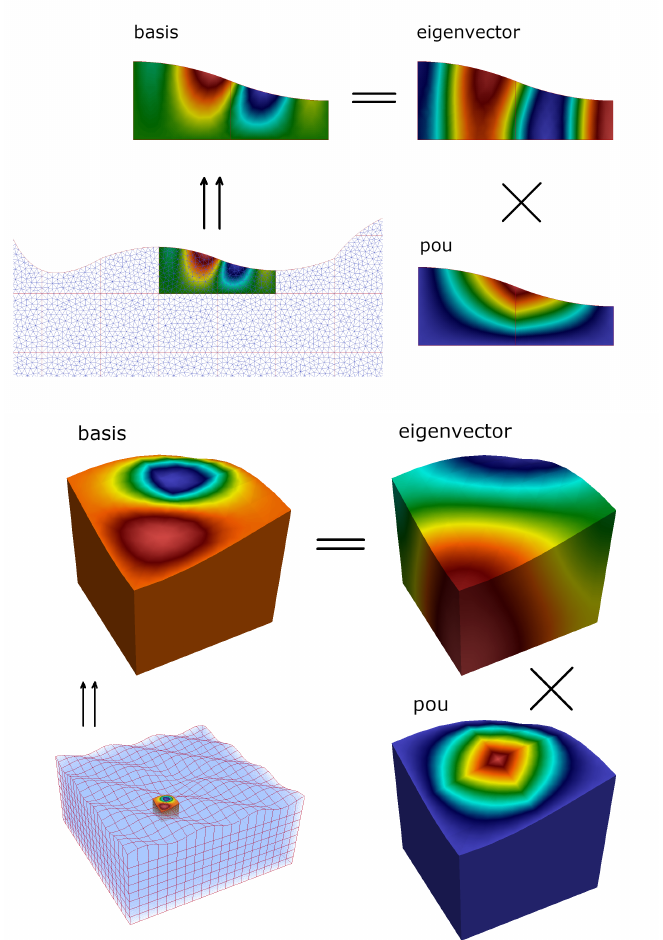
Figure 2. Illustration of Multiscale basis functions that are used to construct coarse grid approxi- mation. Multiscale basis functions are constructed: based on the spectral characteristics of the local problems multiplied by partition of unity functions (the top is 2D and the bottom is